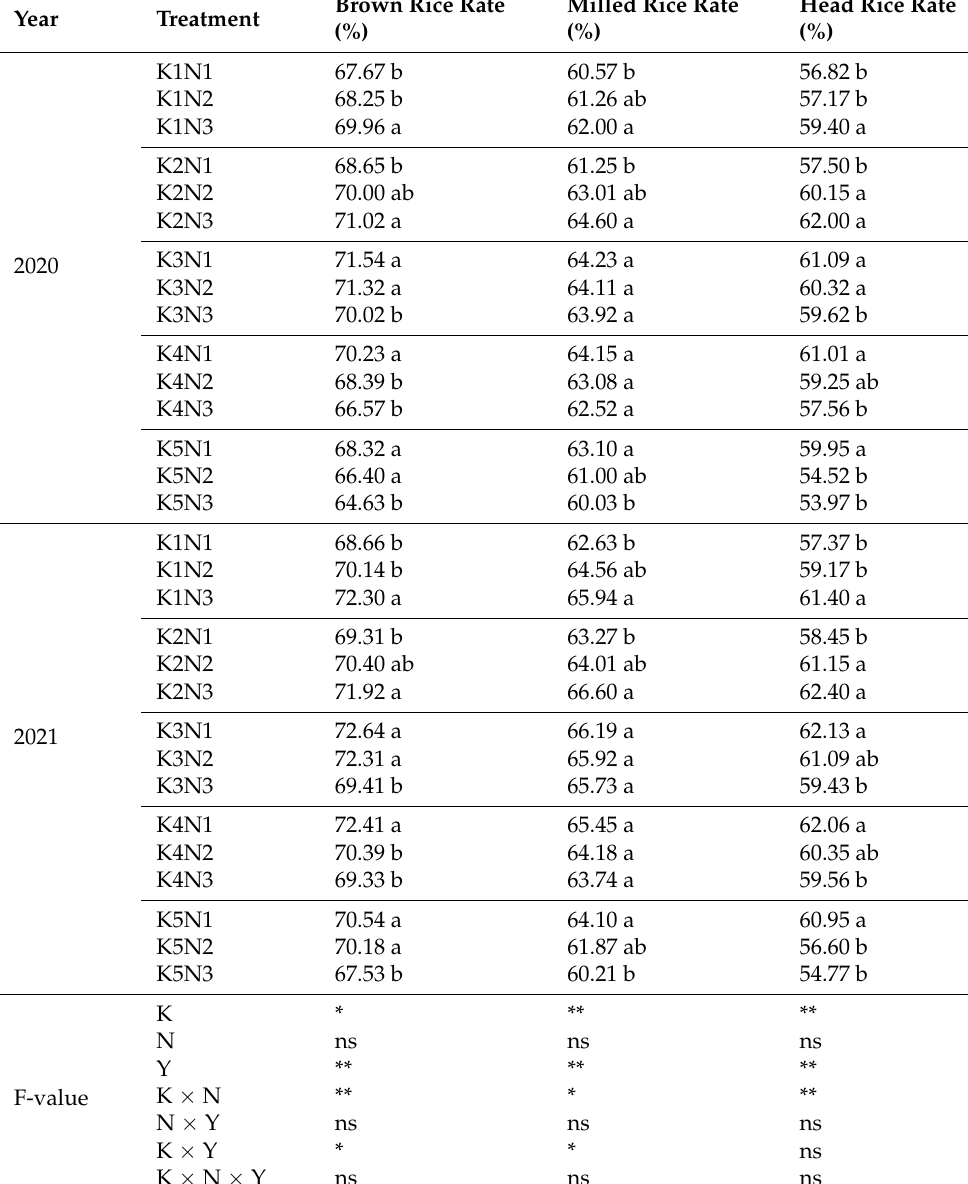
Table 3. Effects of different N and K combined application rates during the panicle stage on rice processing quality in 2020 and 2021, with the results of the three-way